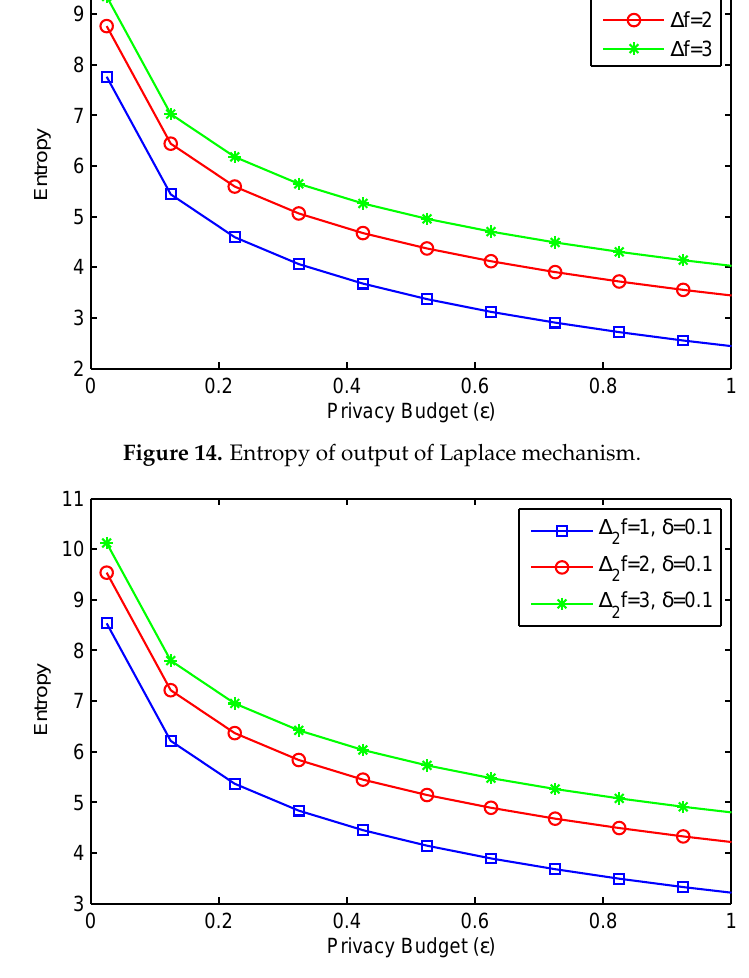
Figure 15. Entropy of output of Gaussian